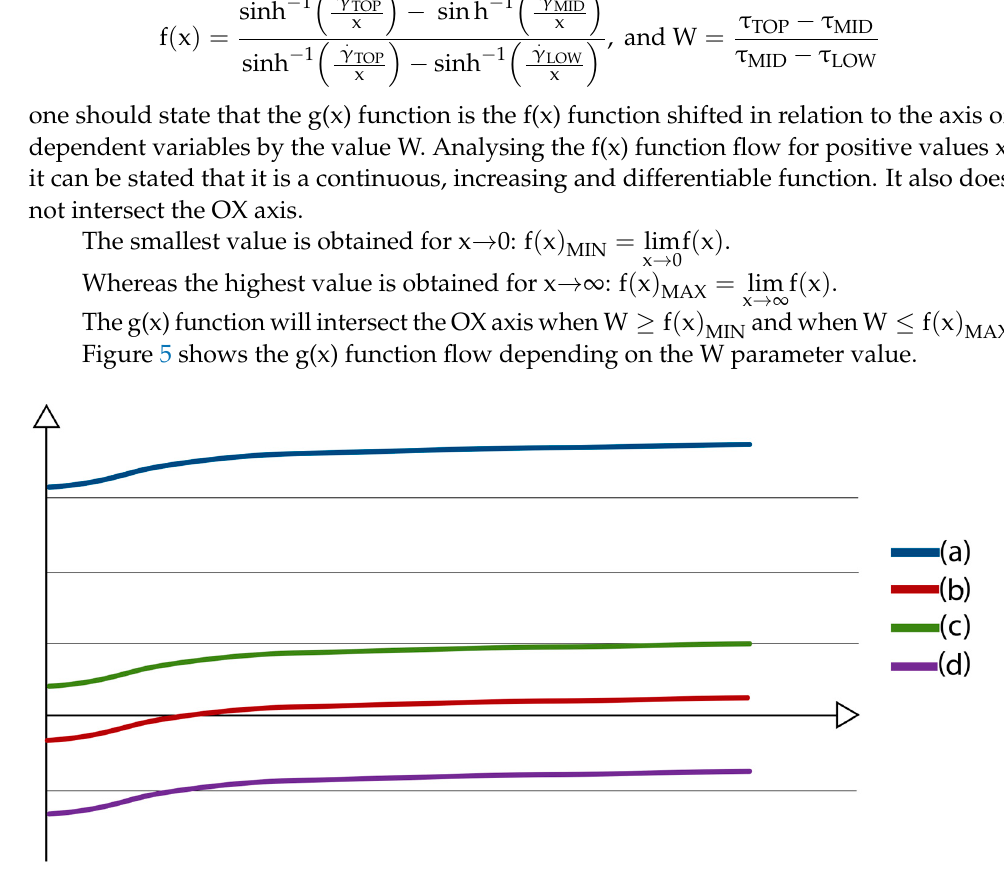
Figure 5. g(x) function flow depending on the W value: ( a ) W = 0, g(x) = f(x); ( b ) f(x) MIN < W < f(x) MAX ;